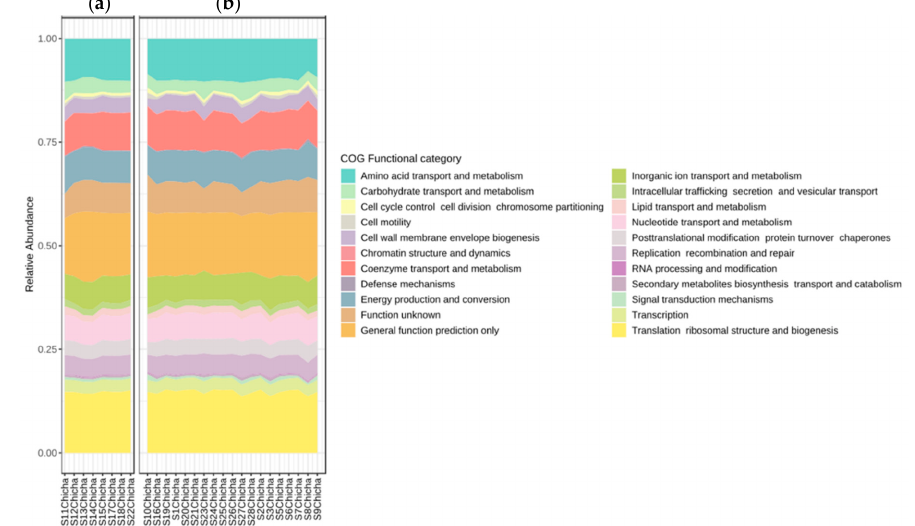
Figure 7. Functional categories defined by KEGG in chicha samples with ( a ) controlled fermentation and ( b ) uncontrolled